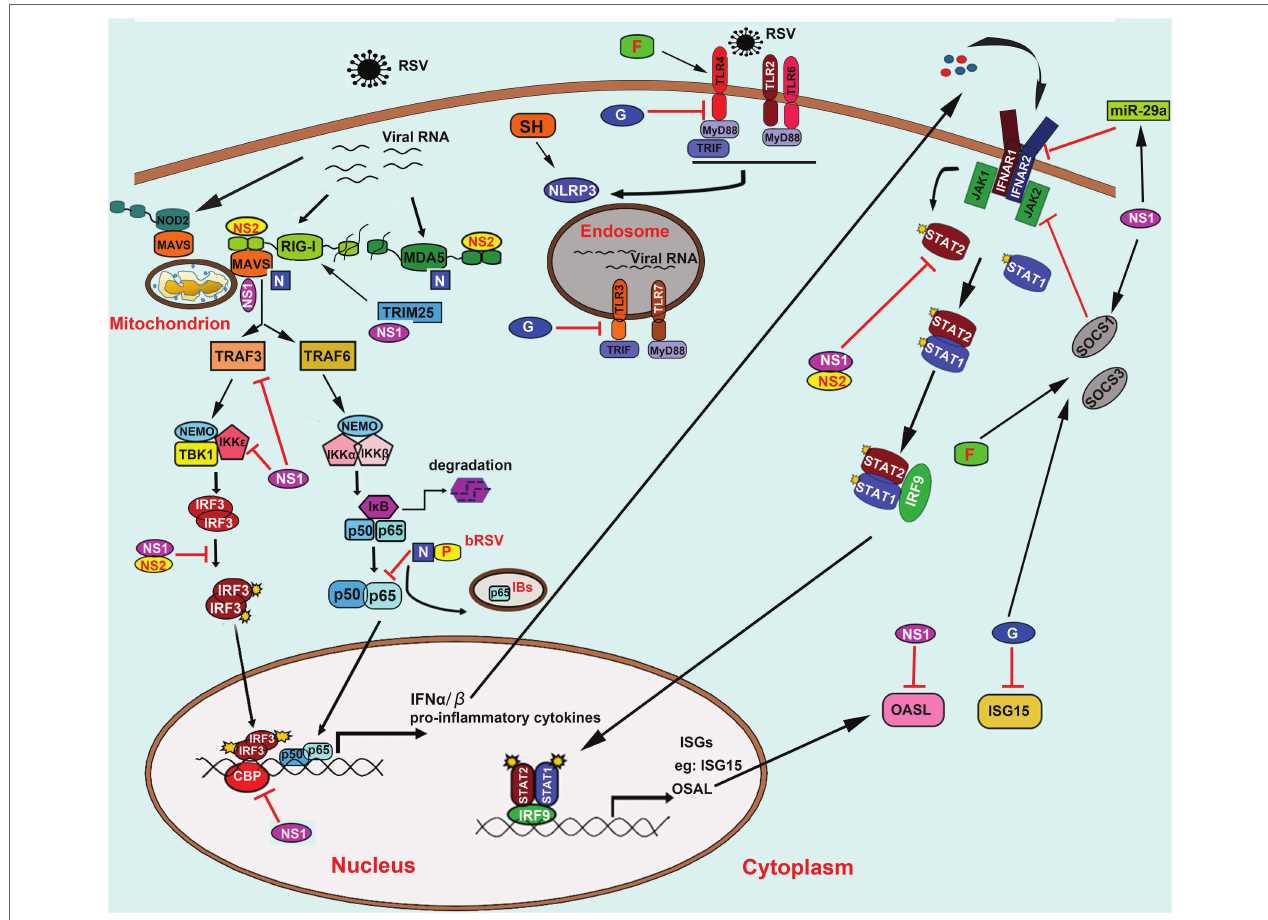
FIGURE 2 | Innate recognition of RSV and its immune evasion mechanisms. RSV is recognized by TLRs including TLR2/6, TLR4, TLR3, and TLR7; RLRs including RIG-I and MDA5; NLRs including NOD2 and NLRP3. NS1/2 mainly mediates the innate immune evasion mechanisms caused by RSV converged in interfering with the RLRs signaling pathway by direct binding to RIG-I, MDA5, adaptor proteins MAVS, and TRIM25. Besides, NS1/2 also induces the decrease of TRAF3, IKK ε , and blocks the phosphorylation of IRF3 and its association to transcriptional coactivator CBP. Moreover, NS1/2 also prevents the JAK/STAT signaling by promoting the degradation of STAT2 and OASL and inhibits the IFNAR synthesis via inducing the expression of miR-29a. Besides, NS1 can also induce the expression of SOCS1 in a RIG-I and TLR3-independent pathway, which further inhibits the phosphorylation of STAT2. The N protein binds to MDA5 and MAVS to inhibit their activation. The bovine RSV (bRSV) N protein can also cooperate with P protein to promote the formation of IBs-like structures to capture the p65 subunit of NF- κ B, which further prevents its translocation to the nucleus. On the one hand, the soluble G protein blocks the TLR3/4-mediated IFN- β production. On the other hand, it also impedes the ISG15 expression. The G protein and F protein induce both SOCS1 and SOCS3, which subsequently interferes with the JAK–STAT pathway to block the IFN-I response. Abbreviation: RSV, respiratory syncytial virus; TLRs, toll-like receptors; RIG-I, retinoic acid-inducible gene I; MDA5, melanoma differentiation associated gene 5; NOD2, nucleotide-binding oligomerization domain 2; NLRP3, the NOD, leucine-rich repeat (LRR)-containing protein 3; NS1/2, non-structural (NS) protein 1 or 2; MAVS, mitochondrial antiviral-signaling protein; TRIM25, tripartite motif-containing protein 25; TRAF3/6, tumor necrosis factor (TNF) receptor-associated factor (TRAF) adapter protein 3 or 6; NF- κ B, nuclear factor kappa-B; I κ B, inhibitor of NF- κ B; IKK ε , inhibitor of I κ B kinase ε ; IRF3, interferon regulatory factor 3; JAK, Janus kinase; STAT, signal transducer and activation of transcription; OASL, 2 ′ -5’-Oligoadenylate synthetases-like protein; IFNAR, IFN- α receptors; SOCS1/3, suppressor of cytokine signaling protein 1 or 3; N; nucleoprotein; P, phosphoprotein; G, glycoprotein; IBs, inclusion bodies; IFN- α / β , interferon α or β ; ISG15, IFN-stimulated gene 15; CBP, cAMP (cyclic adenosine monophosphate) response element-binding protein (CREB)-binding